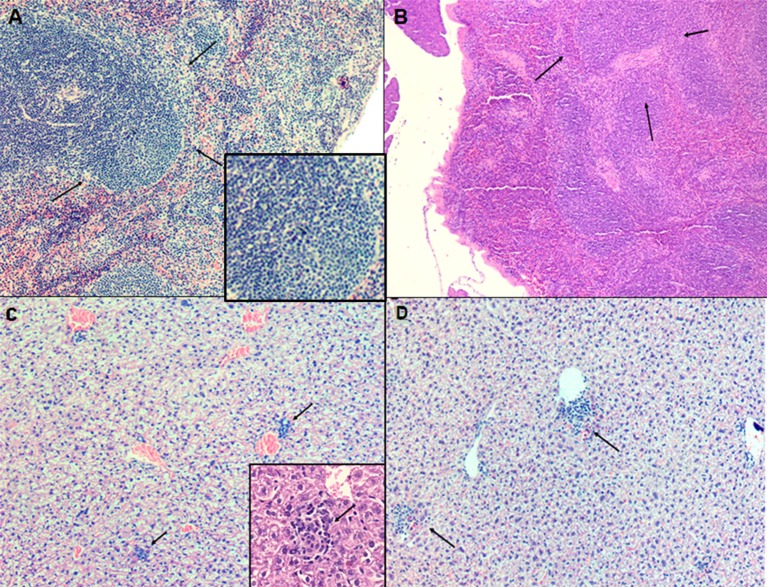
Evaluation of histopathological profile of BALB c mice infected with L. (L.) infantum, after 10 consecutive days of treatment with liposomal sertraline. (A) Spleen of an animal representative of untreated group. (B) Spleen of an animal representative of the group treated with liposomal sertraline at 1 mg/kg. (C) Liver of an animal representative of the untreated control group. (D) Liver of an animal representative of the group treated with liposomal sertraline at 1 mg/kg. Presence of granulomas in all groups (arrows). Staining of H&E, 100× magnification.